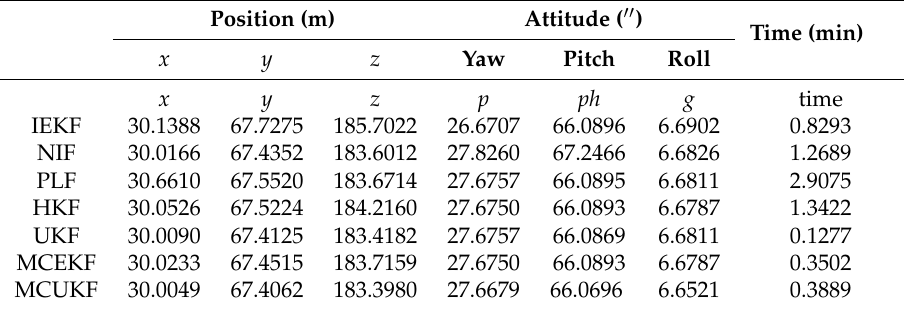
Table 7. RMSE of position, attitude, and time cost of different message under the condition of the Gaussian mixture noises for SINS/CNS deeply integrated